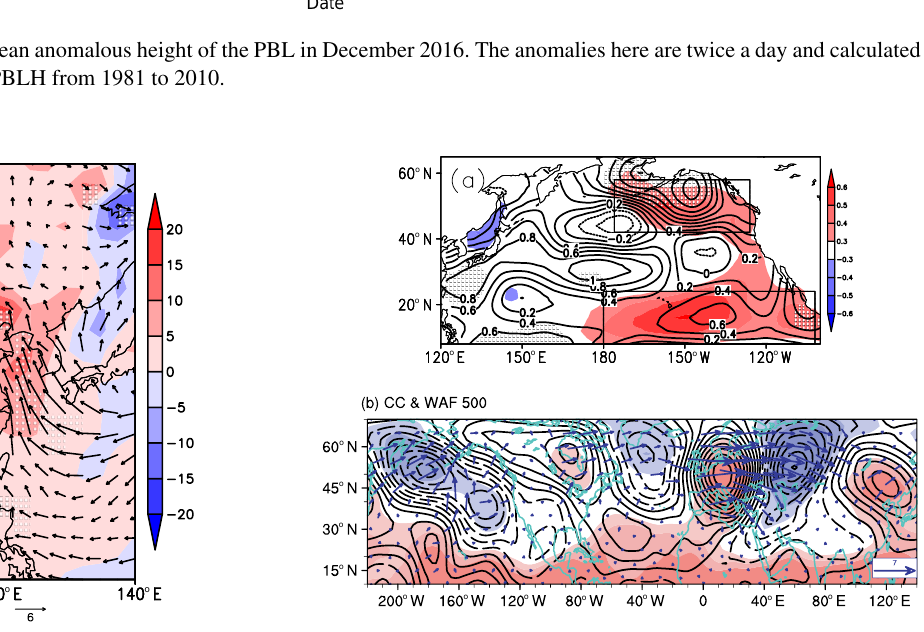
Figure 9. Distribution of the regional atmospheric circulation anomalies, surface wind (arrow), and surface relative humidity (shading) during 16–21 December 2016. The white dots indicate surface relative humidity anomalies exceeding the 95% confidence level ( t test). The anomalies here are calculated with respect to the period from 1981 to 2010.